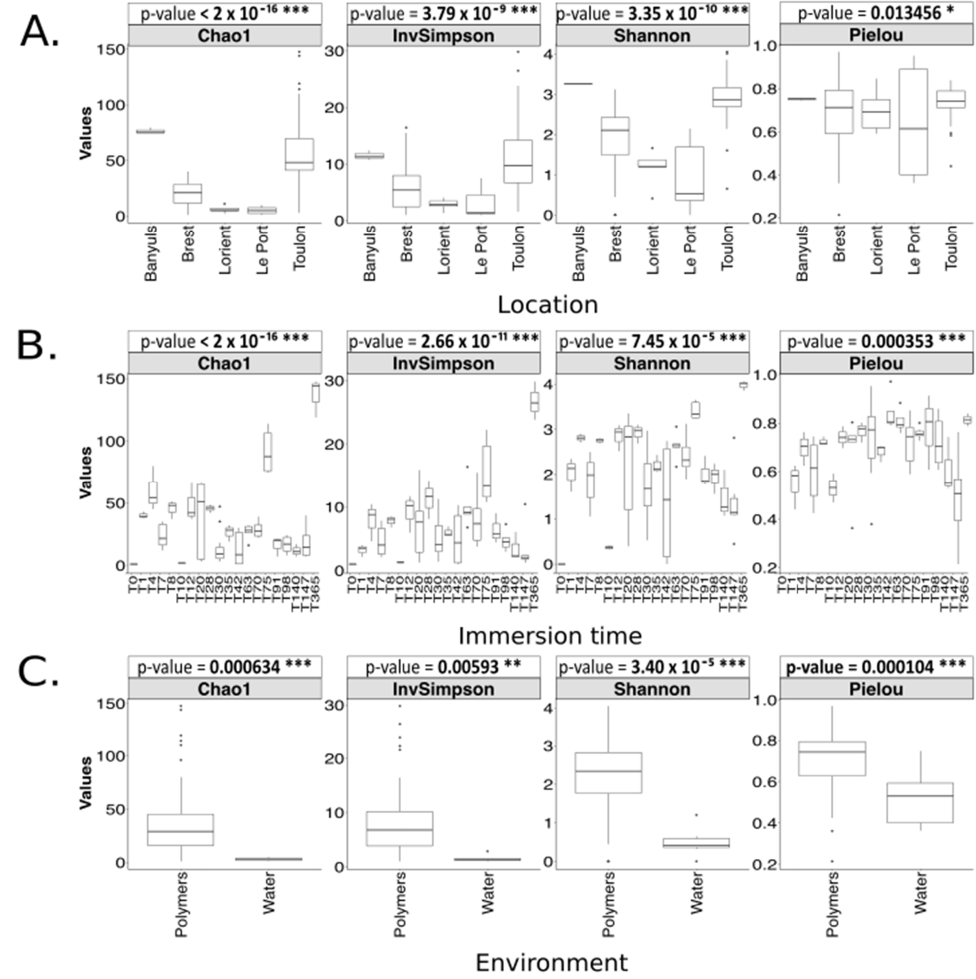
Figure 5. Alpha diversity indices and their associated significance, based on the V4 region of the 18S rRNA gene dataset for the variables ( A ) “Location”, ( B ) “Immersion time”, (days) and ( C ) “Environment”. “*”, “**”, and “***” represent a signi fi cant, highly signi fi cant, and very highly signi fi cant in fl uence of the evaluated factor, respectively.